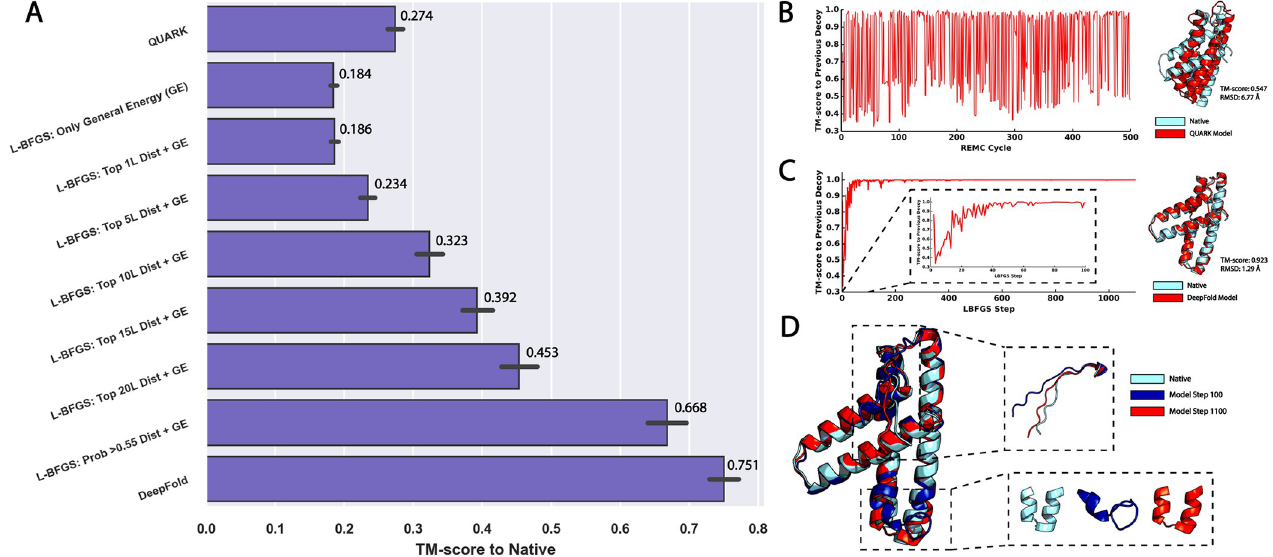
Fig 6. Comparison of DeepFold and QUARK modeling results. A) Evaluation of the modeling accuracy of QUARK and DeepFold guided by different numbers of spatial restraints, where the top n � L distances were selected by sorting the C β distances according to their predicted probabilities. B) Analysis of the conformational changes that occured during the QUARK fragment assembly simulations. The figure plots the TM-score of the decoy at REMC cycle i compared to the decoy at the previous cycle i-1 . The right hand side shows the final QUARK model in red superposed with the native structure in cyan. C) Analysis of the conformational changes that occured during the DeepFold simulations. The figure plots the TM-score of the decoy at L-BFGS step i compared to the decoy at the previous step i-1 , where the right hand side shows the final DeepFold model in red superposed with the native structure in cyan. D) Comparison between the DeepFold model at L-BFGS step 100 (blue) with the model at step 1100 (red) and the experimental structure (cyan). The insets show the areas of the structure that changed the most after the 100 th L-BFGS step.